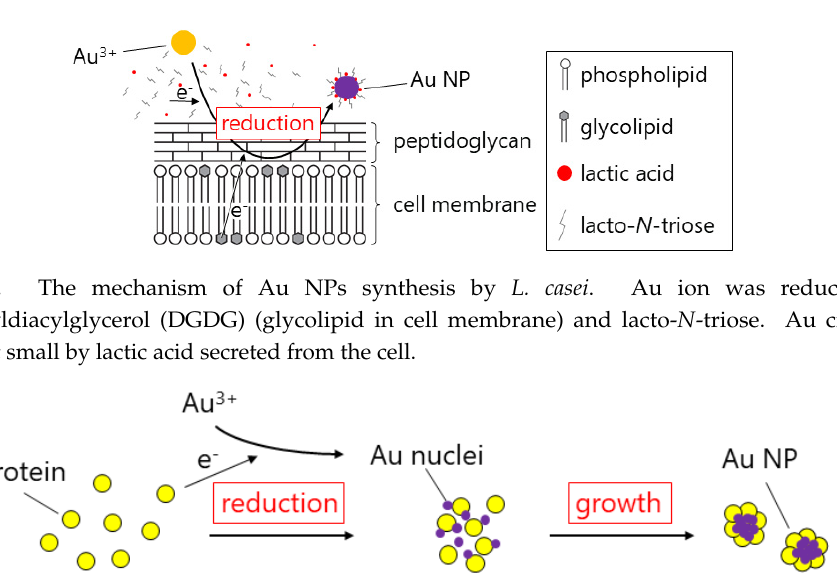
Figure 7. The mechanism of Au NPs synthesis by CFE of B. marisflavi YCIS MN 5. Protein in the CFE reduced Au ion and produced Au nuclei. The Au nuclei would grow to Au NP.